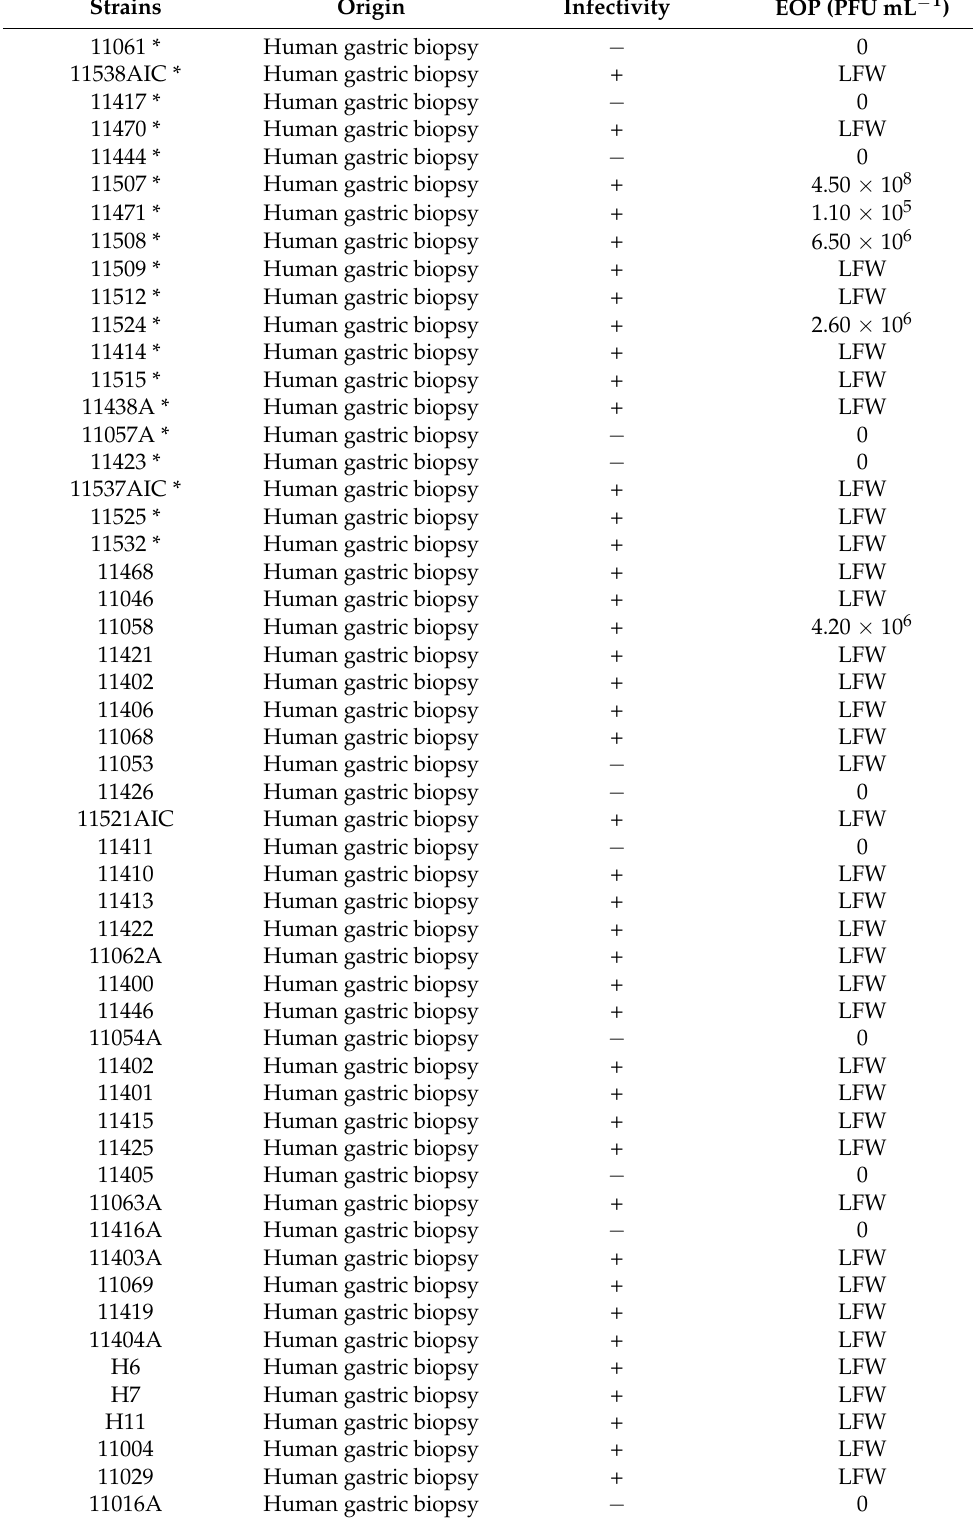
Table 1. HPy1R lytic spectra and efficiency of plating (EOP) against different H. pylori strains. Strains subjected to UV radiation treatment are identified with an asterisk (*). EOP is presented in PFU mL − 1 . EOP negative was scored as 0. LFW represents lysis from